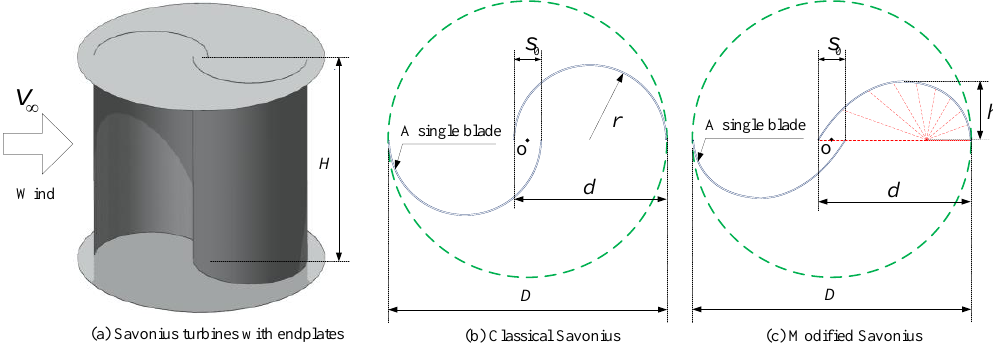
Figure 2. ( a ) Savonius wind turbines; and ( b , c ) simplified 2D model.